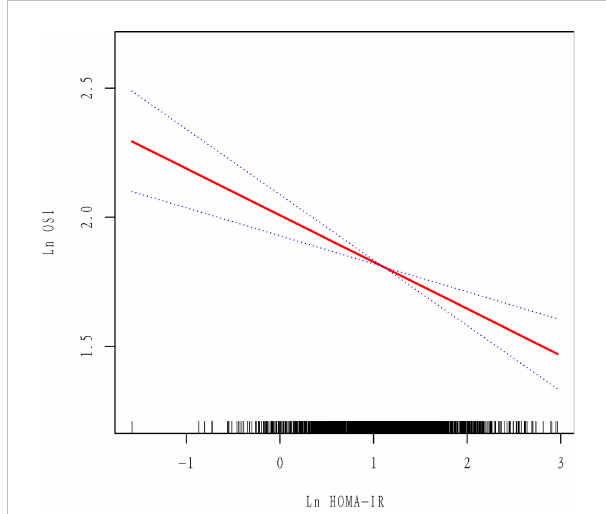
FIGURE 2 Association between Ln HOMA-IR and Ln OSI. All adjusted for age, BMI, AMH, AFC, initial Gn dose, basal FSH and COS protocol. Red line represents the smooth curve fi t between variables and the blue dotted curves represents the 95% of con fi dence